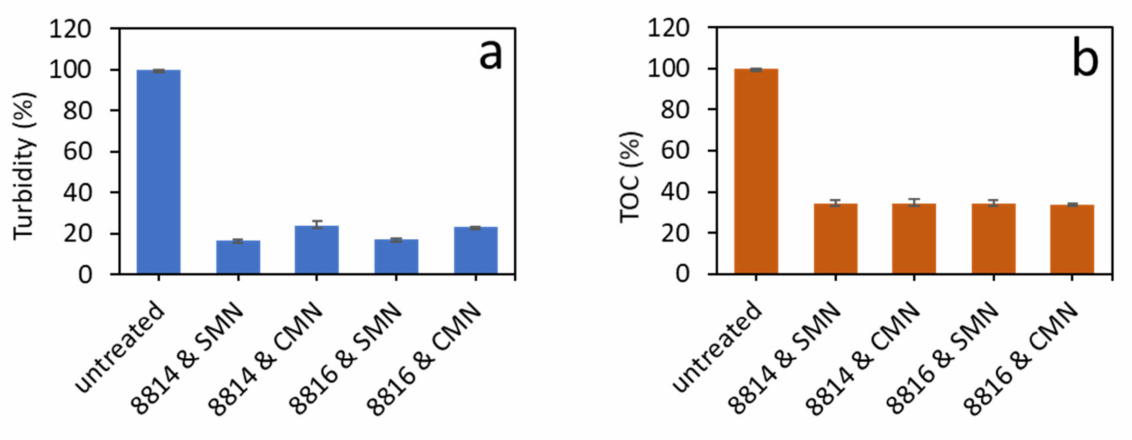
Figure 4. Additional reduction in dairy water ( a ) turbidity and ( b ) TOC upon MNSs